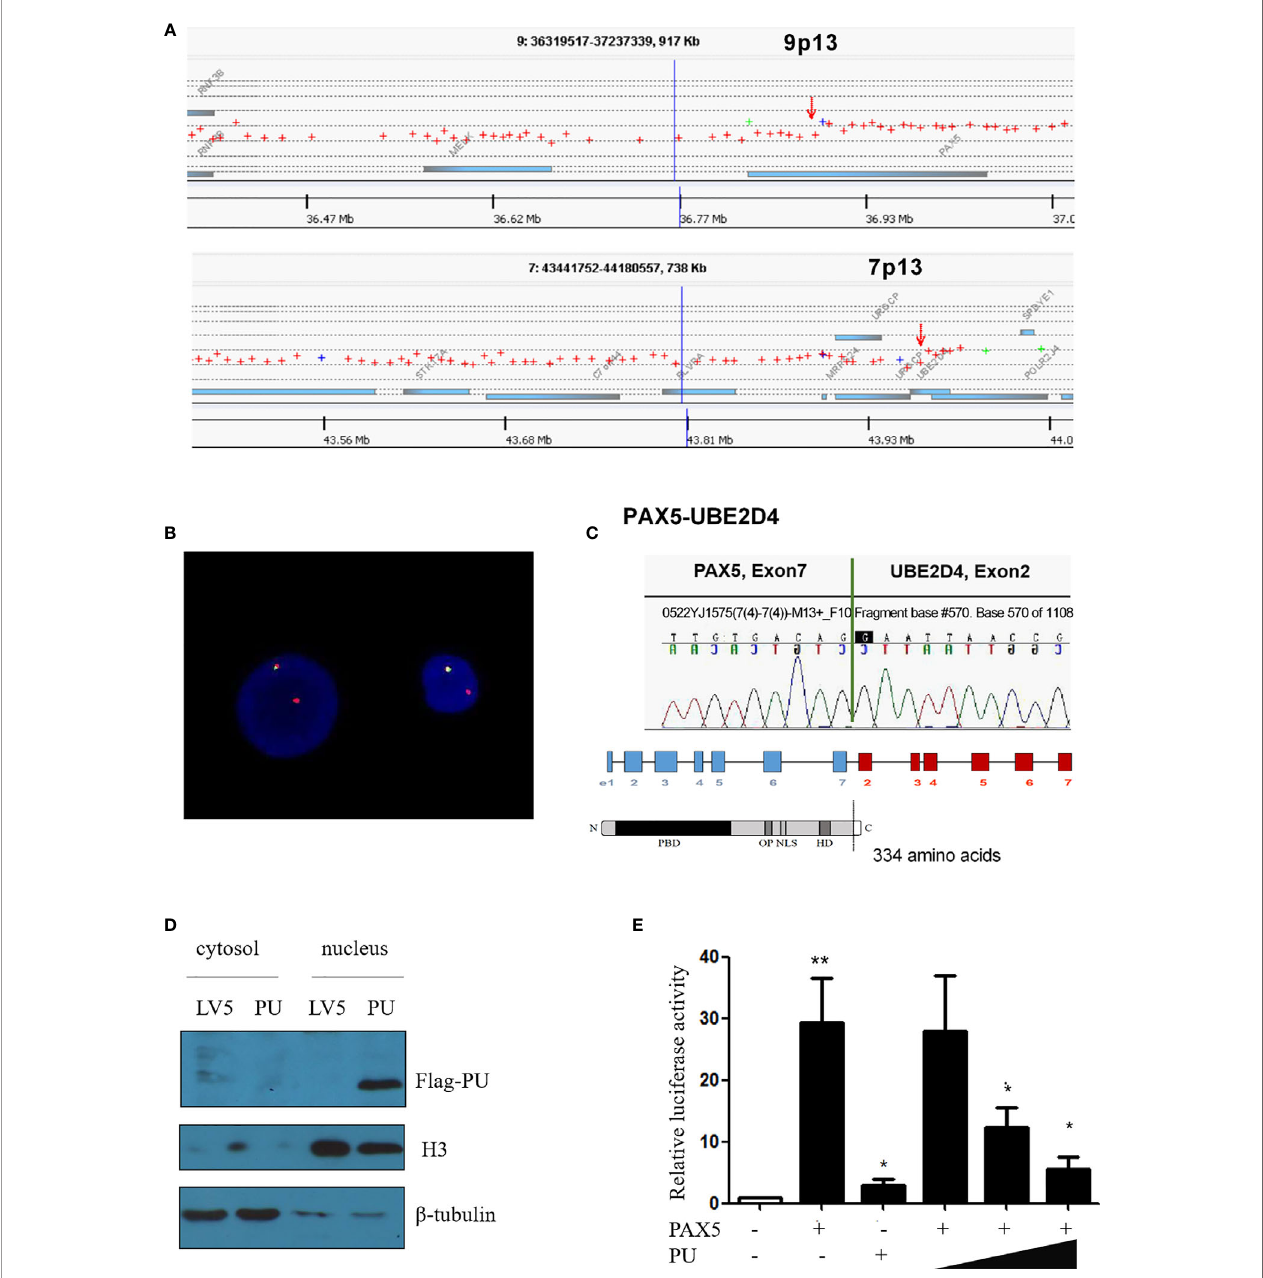
FIGURE 1 | (A) Array comparative genomic hybridization showing the breakpoints of 9p13/PAX5 and 7p13/UBE2D4. (B) FISH assay showing the splitting of the N terminus (green, RP11-344B23) and C-terminus (red, RP11-652D9) of WT PAX5. (C) Sanger sequencing con fi rmed that PAX5 exon 7 was fused out-of-frame with UBE2D4 exon 2, and the schematics show the domains of the PAX5-UBE2D4 (PU) fusion protein, including PBD (DNA-binding domain), OP (octapeptide motif), NLS (nuclear localization sequence) and HD (homeodomain), and an additional 19-amino acid tail encoded by the UBE2D4 gene. (D) Nuclear localization of the PU fusion protein as shown by a nucleus and cytosol separation assay. (E) The transcription activity of the PU fusion and its dominant negative effect on PAX5 transcription activity based on the CD19 promoter luciferase reporter assay. P values are from Fisher ’ s exact test. *P ≤ 0.05, **P ≤